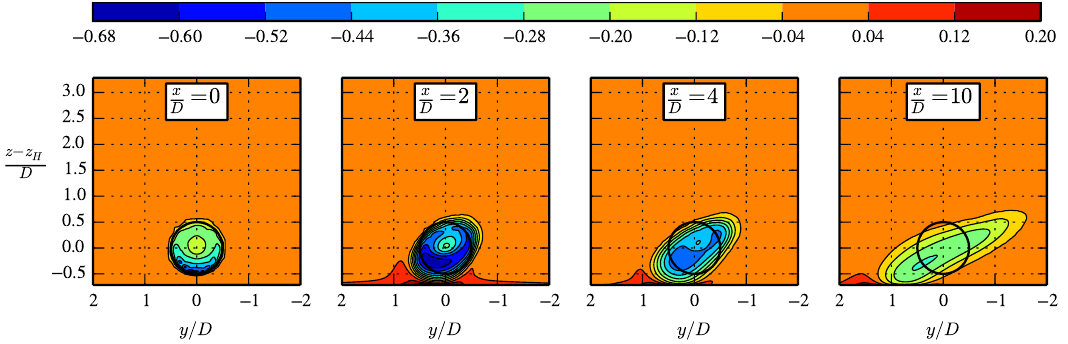
Figure 10. Stream-wise velocity subtracted and normalized by the free stream ( U − U inflow ) /U inflow at several downstream cross planes for a single wake in a shallow ABL. AD is shown as a black circle.